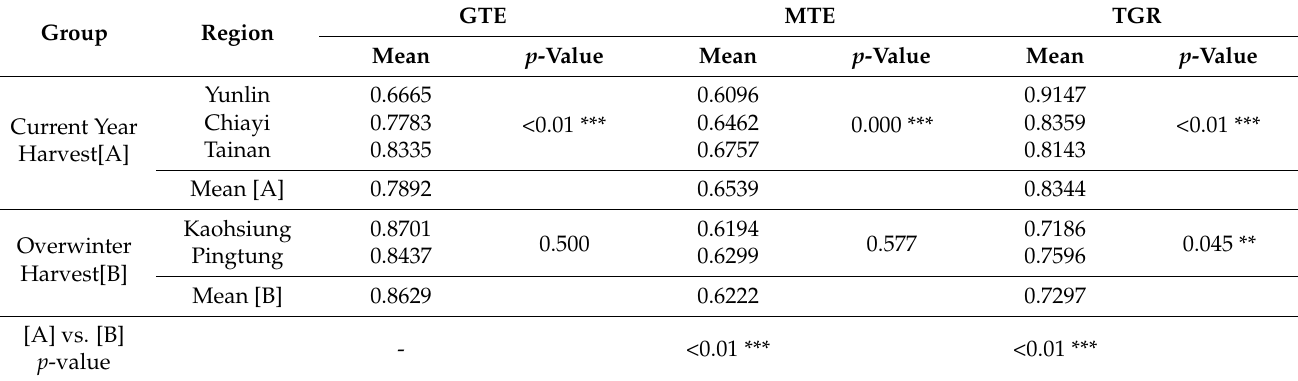
Table 3. Non-parametric test for group technical efficiency (GTE), metafrontier technical efficiency (MTE), and technical gap rate (TGR) between two groups.